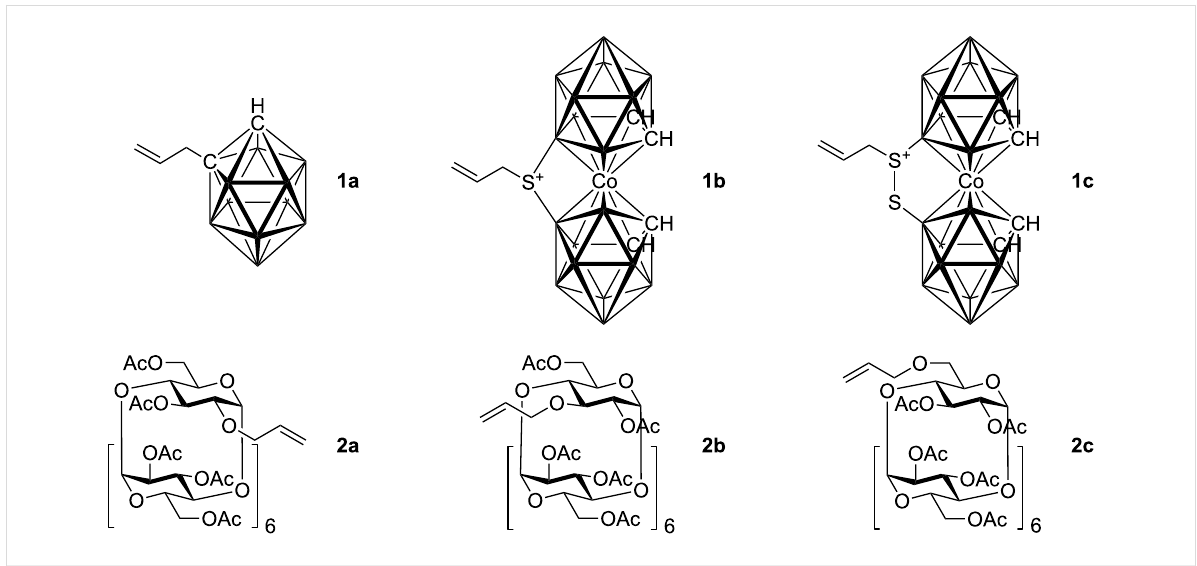
Figure 1: Starting allylcarboranes 1a – 1c and O -allylcyclodextrins 2a – 2c